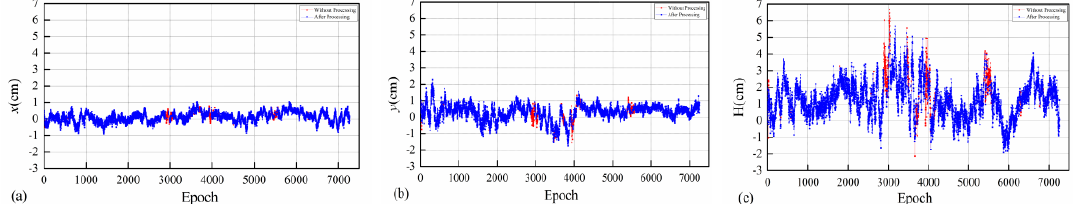
Figure 5. Differences in position in relation to the coordinate time series of the monitoring point: ( a ) x direction; ( b ) y direction; ( c ) H direction.